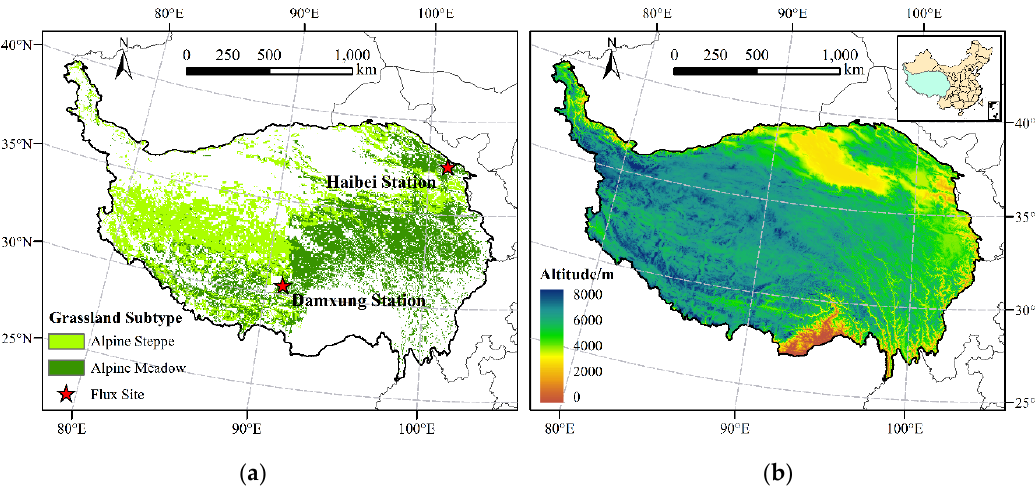
Figure 1. Spatial distributions of grassland subtypes and elevations on the Tibetan Plateau (TP). ( a ) Grassland subtypes; ( b ) Elevation.